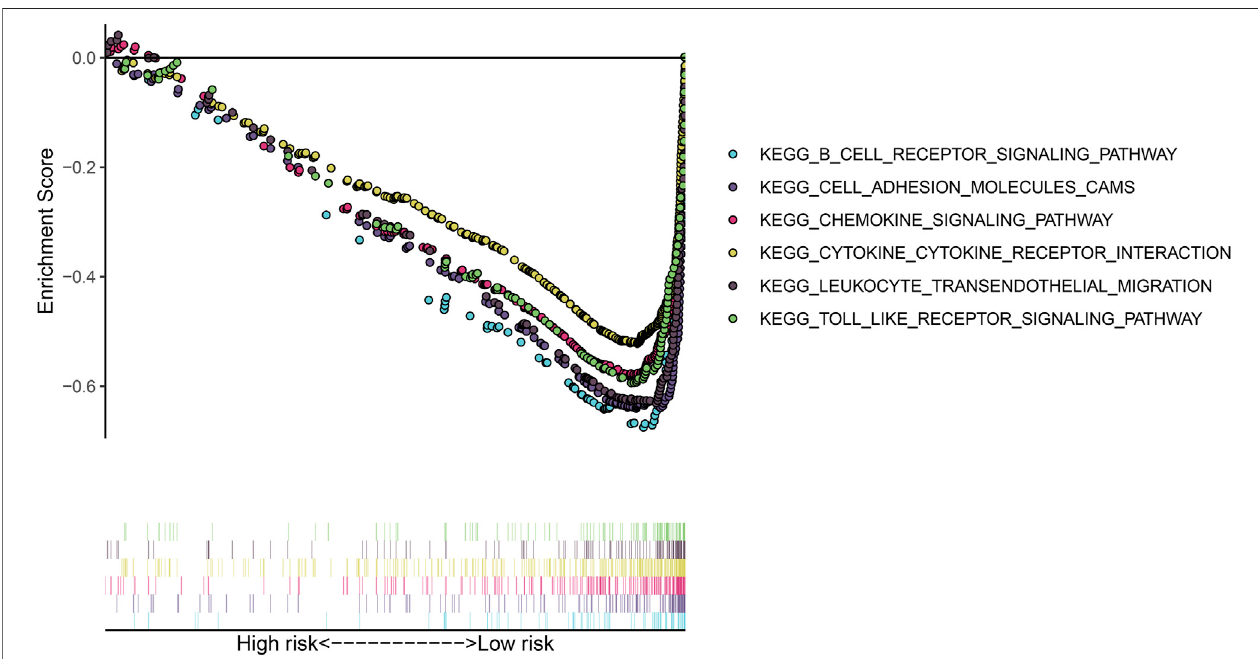
FIGURE 6 | Gene set enrichment analysis (GSEA) for the KEGG pathways associated with the gene